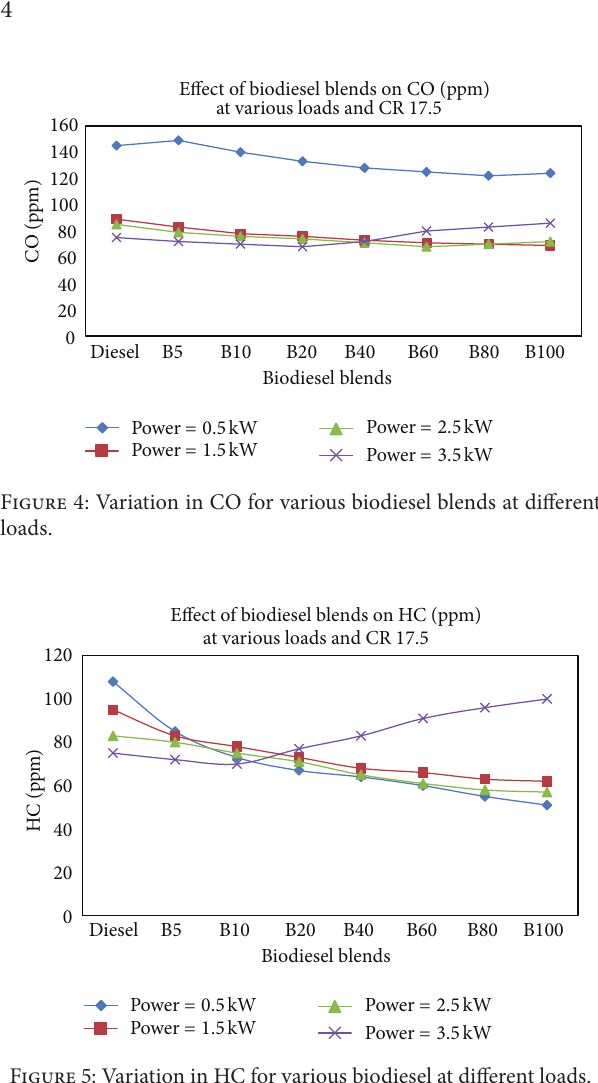
Figure 5: Variation in HC for various biodiesel at different loads.